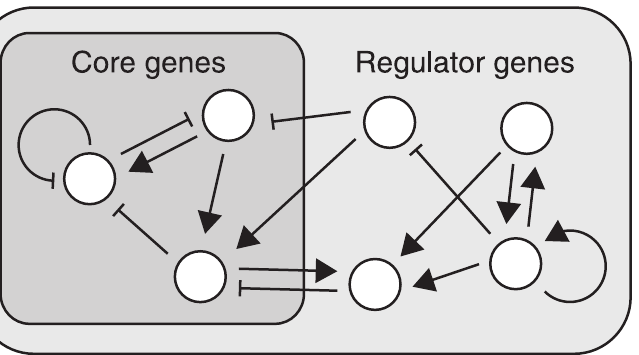
Fig 1. Schematic representation of the gene regulatory network. Each white circle represents a gene. Genes regulate the expression of other genes (including self-regulation). Triangular and flat arrowheads represent activating and inhibitory interactions,